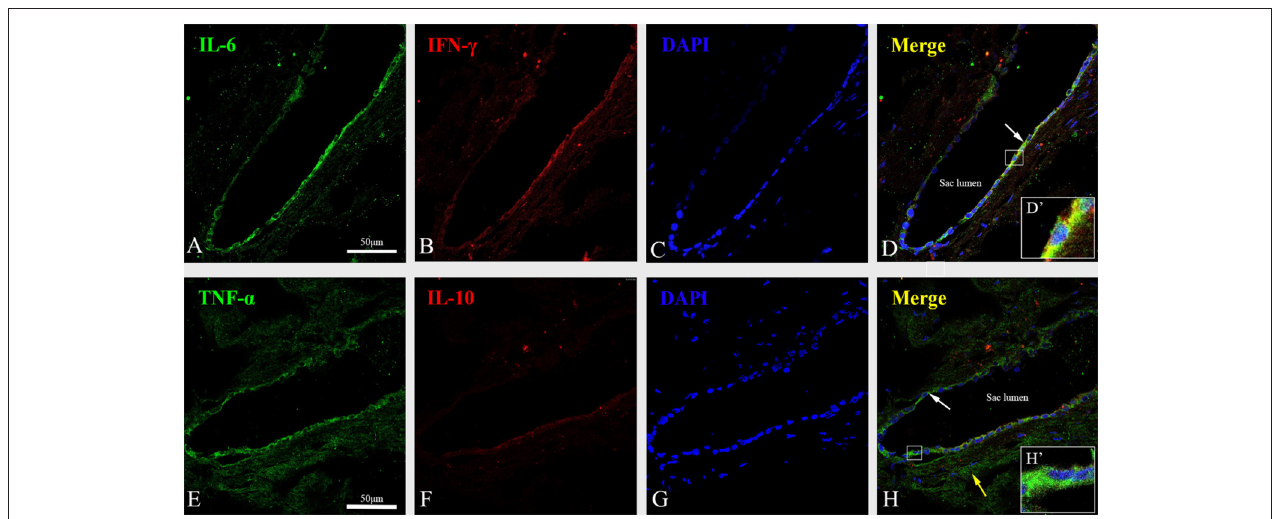
FIGURE 6 | Immunofluorescent staining showed a strong cytoplasmic immunofluorescence signal for IL-6 (green) (A) , IFN- γ (red) (B) and TNF- α (green) (E) , and a minimal cytoplasmic immunofluorescence signal for IL-10 (red) (F) along with the marker of nuclei, DAPI (blue) (C,G) in the proximal extraosseous part of the ES in patient no. 8 with MD. (D) The co-localization regions of IL-6 and IFN- γ showed color in yellow in ES epithelia cells (arrow) in the merged image. The framed area is magnified in (D ′ ), showing that IFN γ and IL-6 were mainly expressed in the cytoplasm and membrane of the ES epithelium. (H) Merged image of immunofluorescent labeling for TNF- α and IL-10 showed color in green in ES epithelia cells (white arrow) and the sub-epithelial tissue and Sub-epithelial fibrocytes (yellow arrow). The framed area is magnified in (H ′ ), showing the expression of TNF- α was localized in the cytoplasm and membrane of the ES epithelium. MD, Meniere’s disease; ES, endolymphatic sac. Scale bars: (A–H) 50 µ